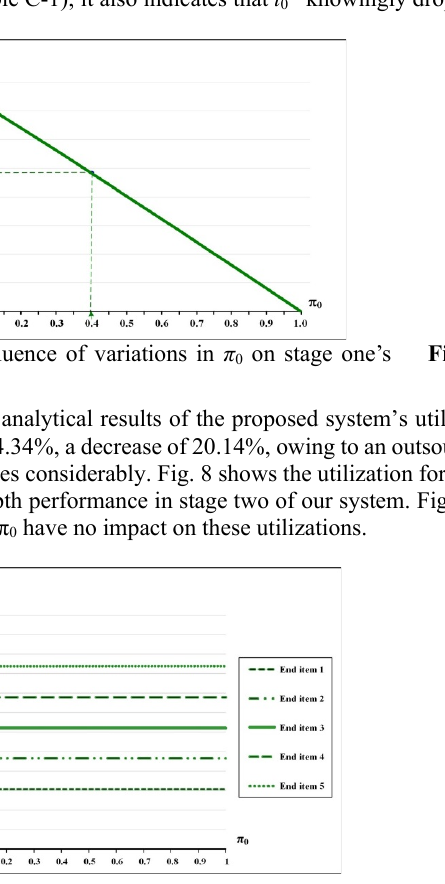
Fig. 8. The utilization for each end item relating to π 0 Fig. 9. Comparing the utilization of this research with